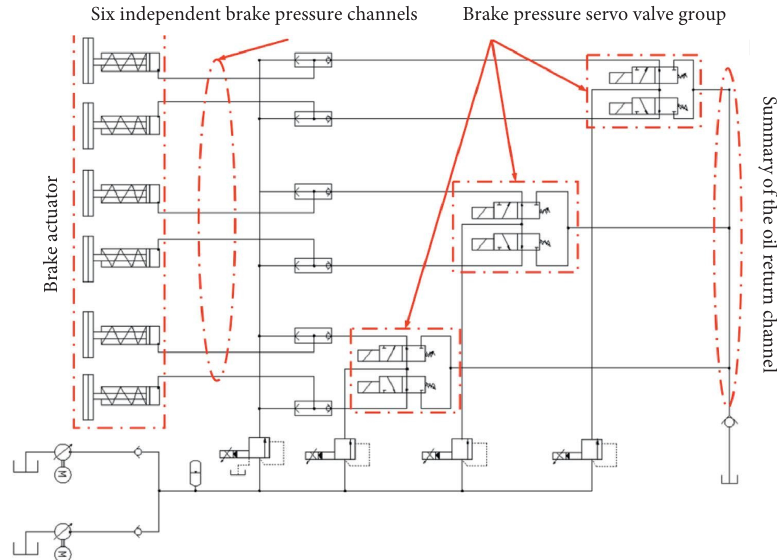
Figure 12: 6-valve parallel brake servo control